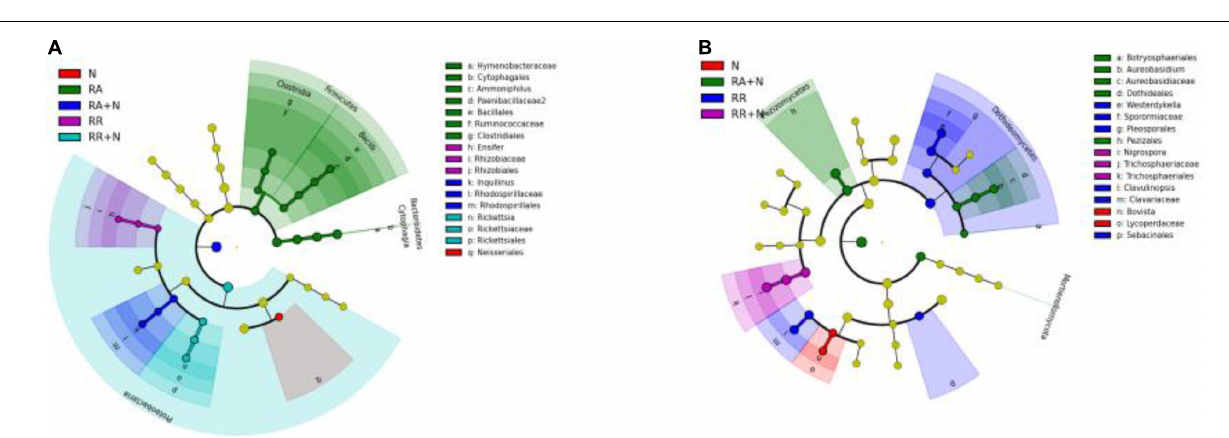
FIGURE 4 | Cladogram indicates the phylogenetic distribution of bacterial lineages ( P = 0.05, LDA = 2.0) (A) and fungal lineages ( P = 0.05, LDA = 4.0) (B) under the treatment of altered nitrogen addition and rainfall patterns. Each circle’s diameter is proportional to the given taxon’s relative abundance ( n = 5). Different treatments: Con: Control; RR: Rainfall reduction; RA: Rainfall addition; N: Nitrogen addition; RR + N: Rainfall reduction and Nitrogen addition; RA + N: Rainfall addition and Nitrogen